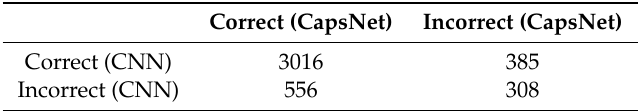
Table 5. Prediction results of our CapsNet and CNN models on the MR dataset.